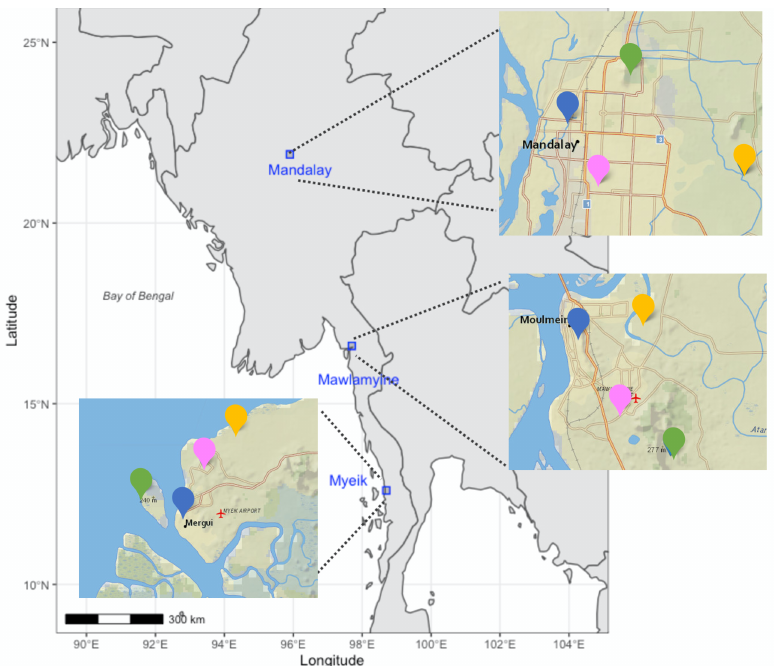
Figure 1. Map of Myanmar depicting the sampling localities (Mandalay, Mawlamyine, and Myeik) and the four areas under different anthropogenic disturbance where the mist-nets were set up for capturing birds (blue marks: downtown, pink: university campus, yellow: paddy fields, and green: